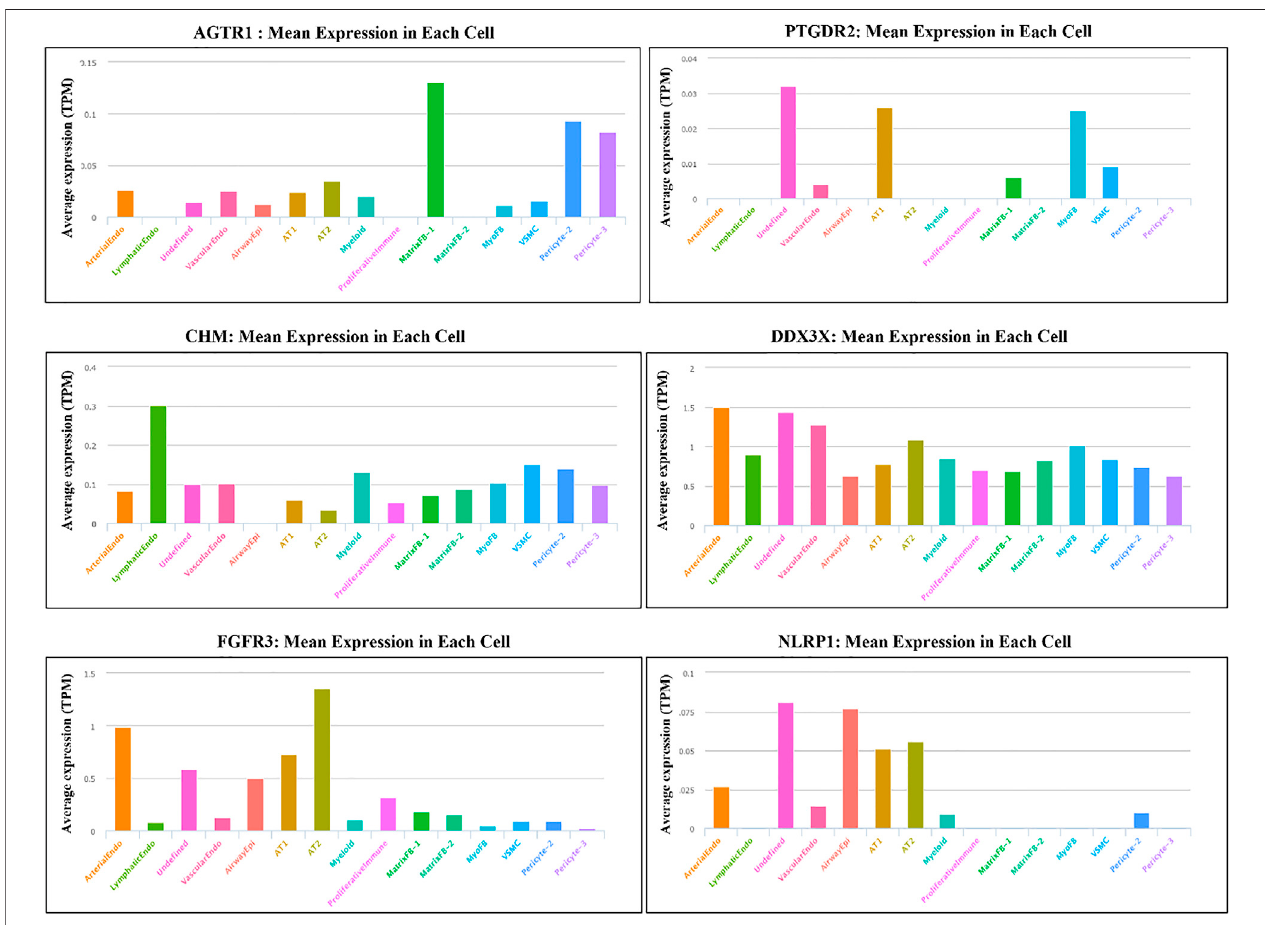
FIGURE 6 | The mRNA expression levels of different candidate genes in different lung cell populations using Single-cell RNA analysis of LungGENS web-based tool.